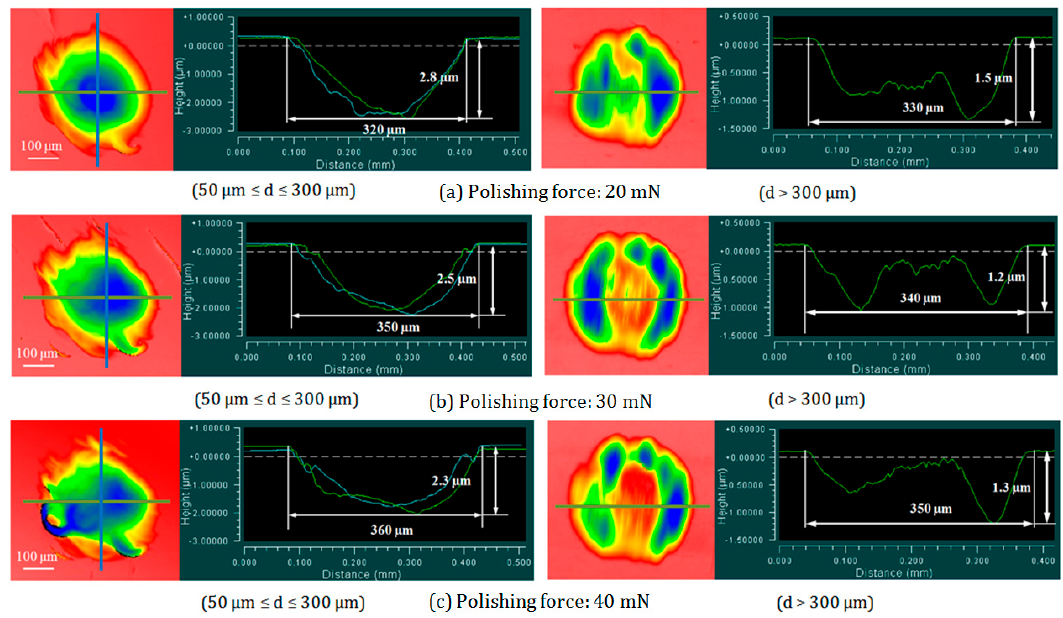
Figure 15. Comparison of tool influence functions with 50 μ m ≤ d ≤ 300 μ m and d > 300 μ m.